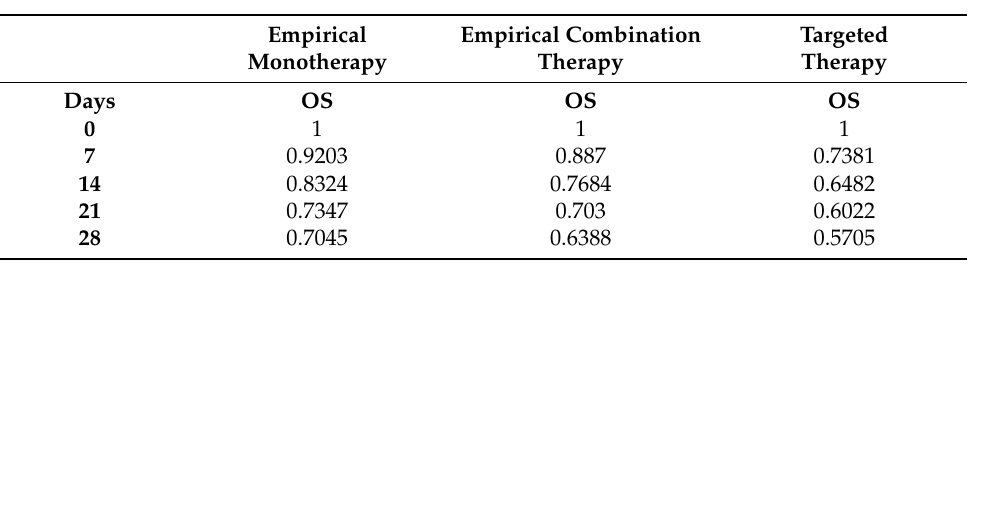
Appropriate Empirical Monotherapy